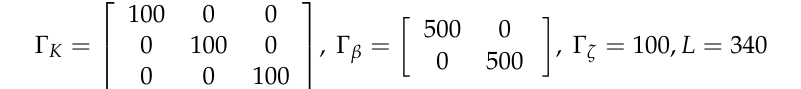
Figure 5. Controller Adaptive gains for the three controllers. Figure 6 shows the unknown uncertainty parameters estimation where again the os- cillatory profiles were clear in the response of both the MRAC and MRAC with adaptive response estimator, while the MRAC with a nonlinear disturbance observer showed a smoother and more stabilized action. Figure 7 shows the unknown adaptive uncertainty parameters estimation where again the oscillatory profile was clear in the response of both the MRAC and the other controller with the adaptive disturbance estimator, while the MRAC with the nonlinear disturbance observer showed a smoother and more stabilized adaptive uncertainty pa- rameters action.